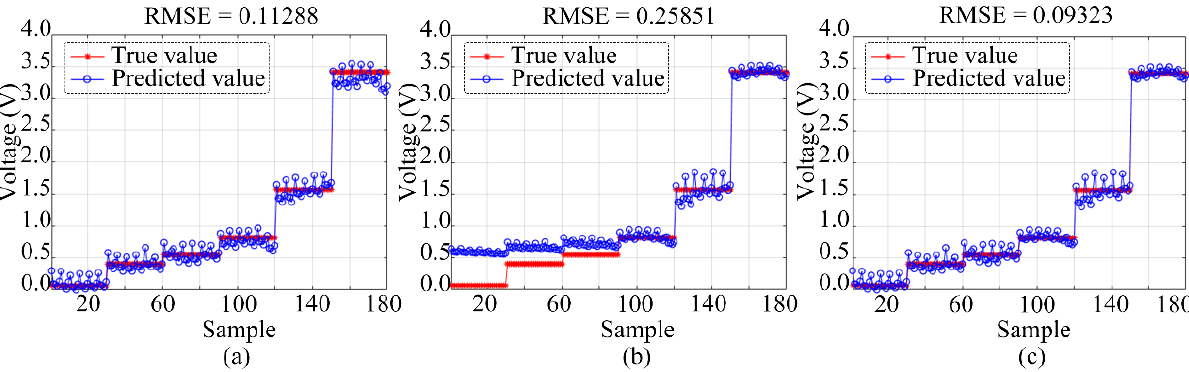
Figure 11. Corrected RMSE of test data set: ( a ) MR model, ( b ) GA-BP model, and ( c ) MR combined with GA-BP model.